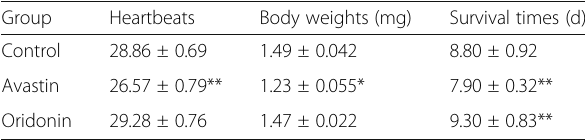
Table 3 Comparison of the heartbeats, body weights, and survival times between the experimental groups